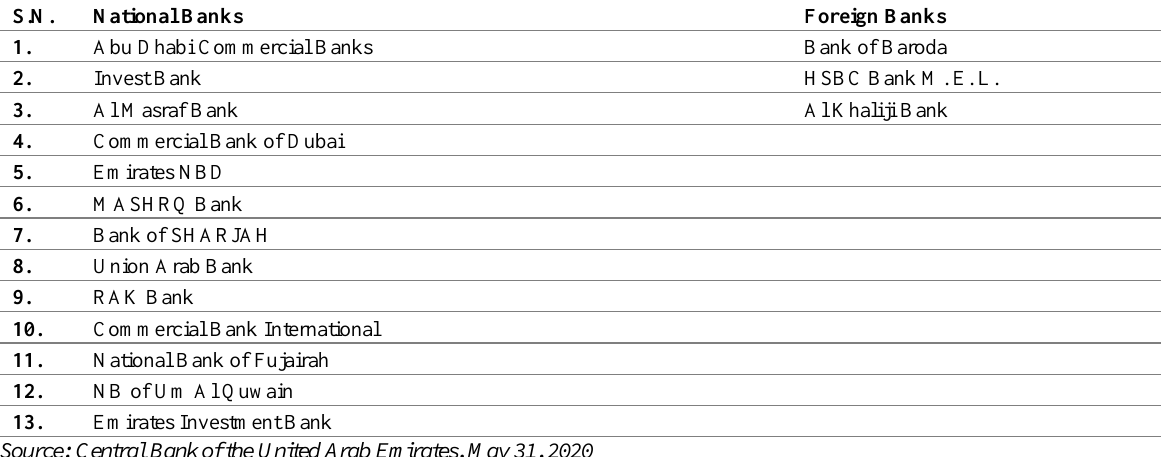
Table 2: The sample of the study - Commercial Banks Operating in the UAE